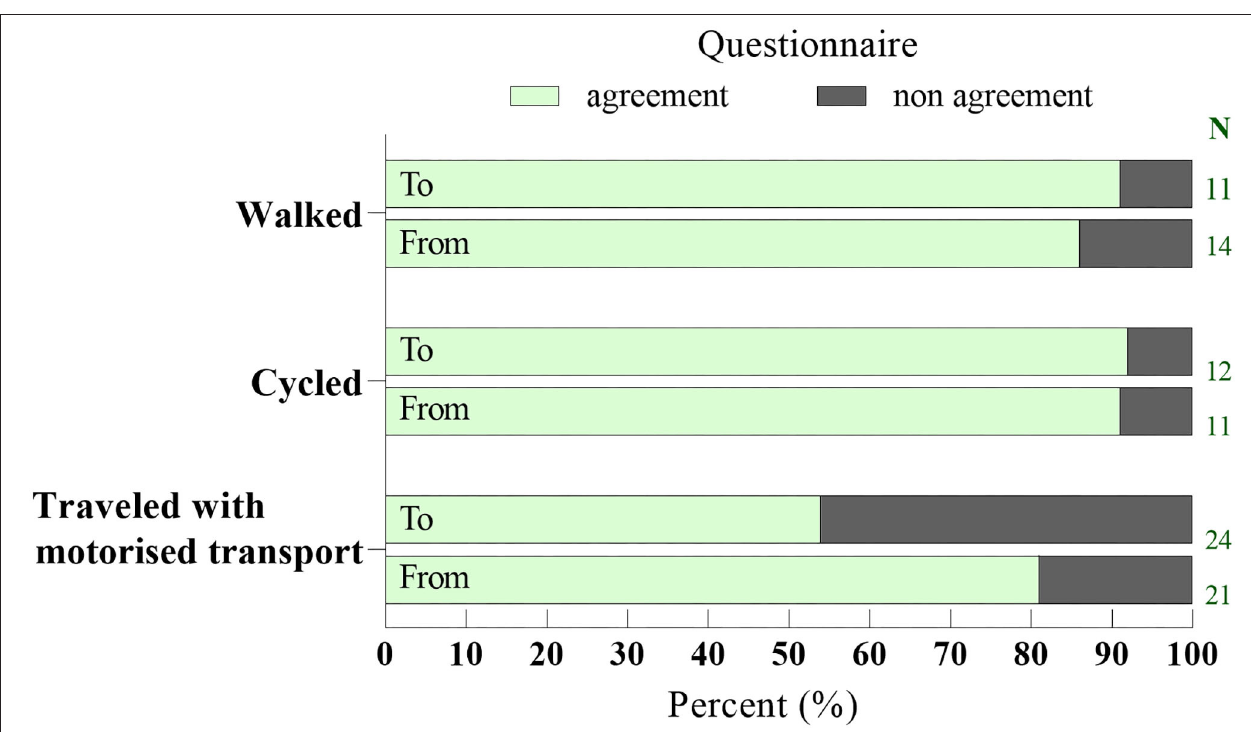
diary and that reported in the HBSC